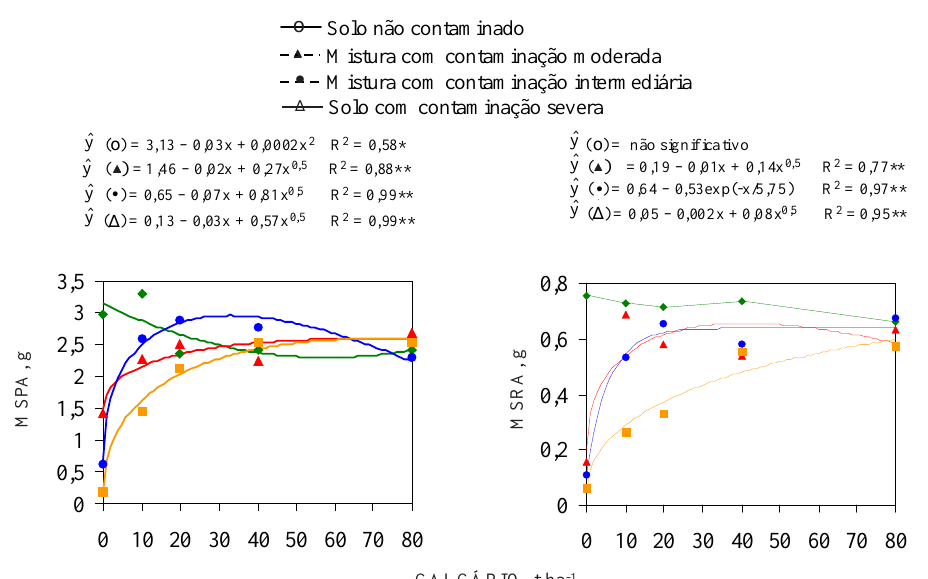
Figura 3. Produção de matéria seca da parte aérea (MSPA) e de raízes (MSRA) de Eucalyptus camaldulensis em solo com diferentes doses de calcário e com níveis de contaminação com zinco e cádmio. * e ** Significativos a 1 e 5 % pelo teste de F,